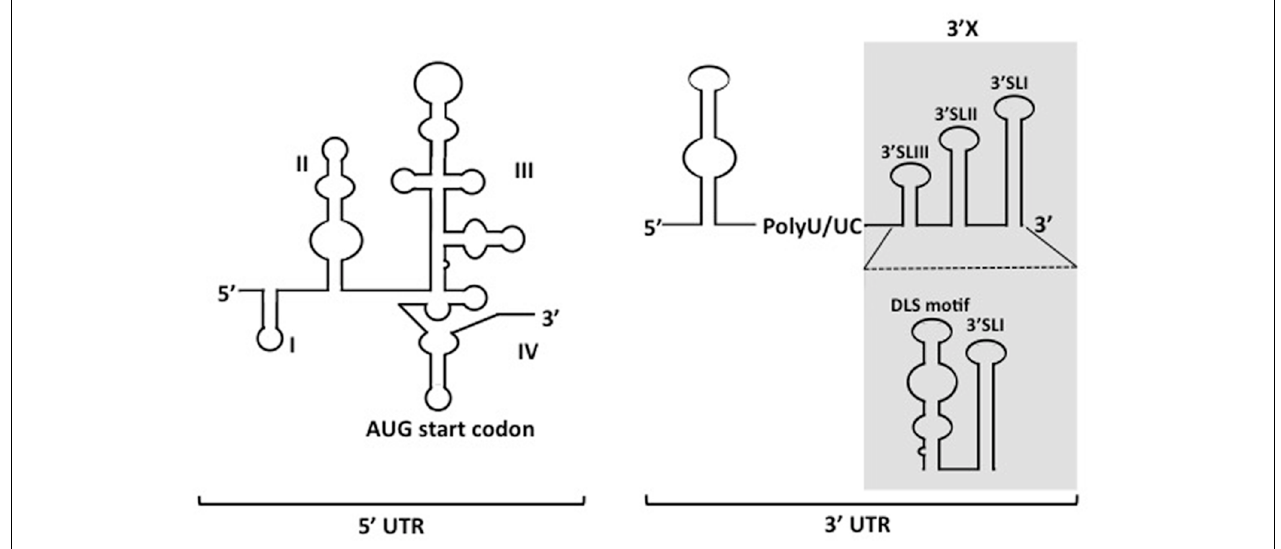
FIGURE 1 | Depicted secondary structures of 5 (cid:48) - and 3 (cid:48) UTRs of HCV genome. The 5 (cid:48) UTR contains four structured domains (I–IV). The translational start codon is indicated. Two types of conformations for the 3 (cid:48) X region ( shadowed region ) within the 3 (cid:48) UTR have been